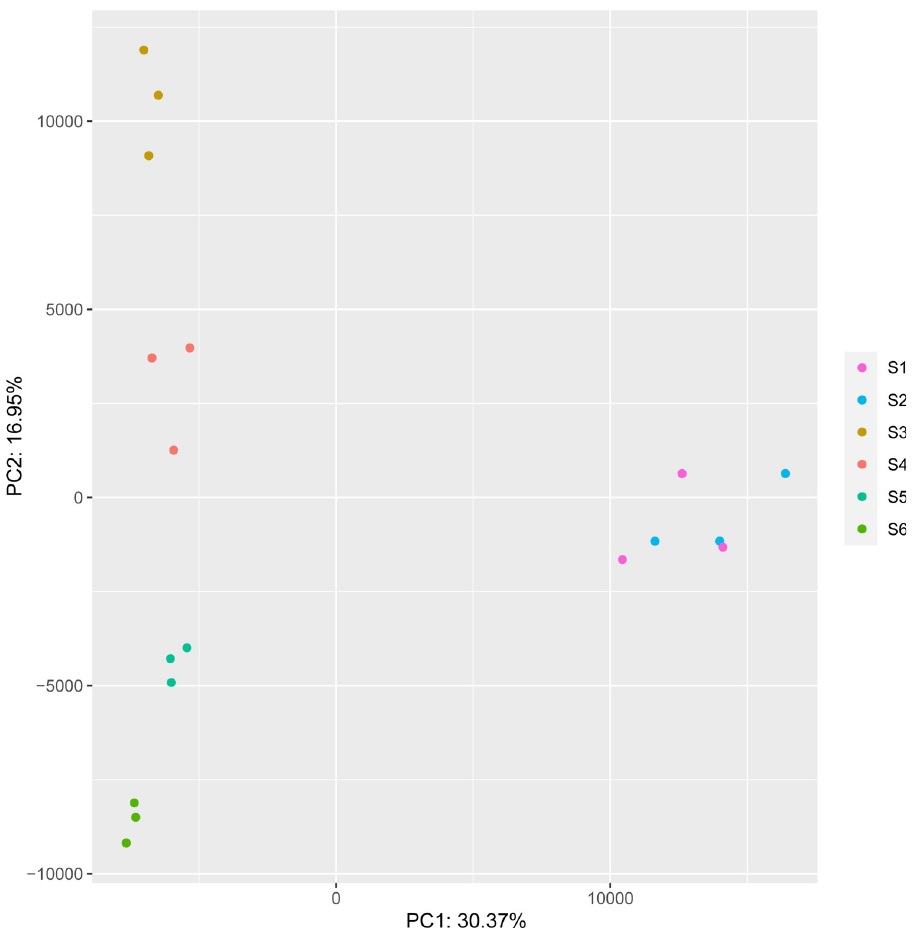
Fig 2. Principle Component Analysis (PCA) of variability in DEGs observed across samples. Colors are used to differentiate between samples: purple, blue, brown, red, green, and cyan represent leaf bud, flower bud, initial flower, bloom flower, pad fruit, and cup fruit,